Question: Write a single sentence explaining what this figure depicts.
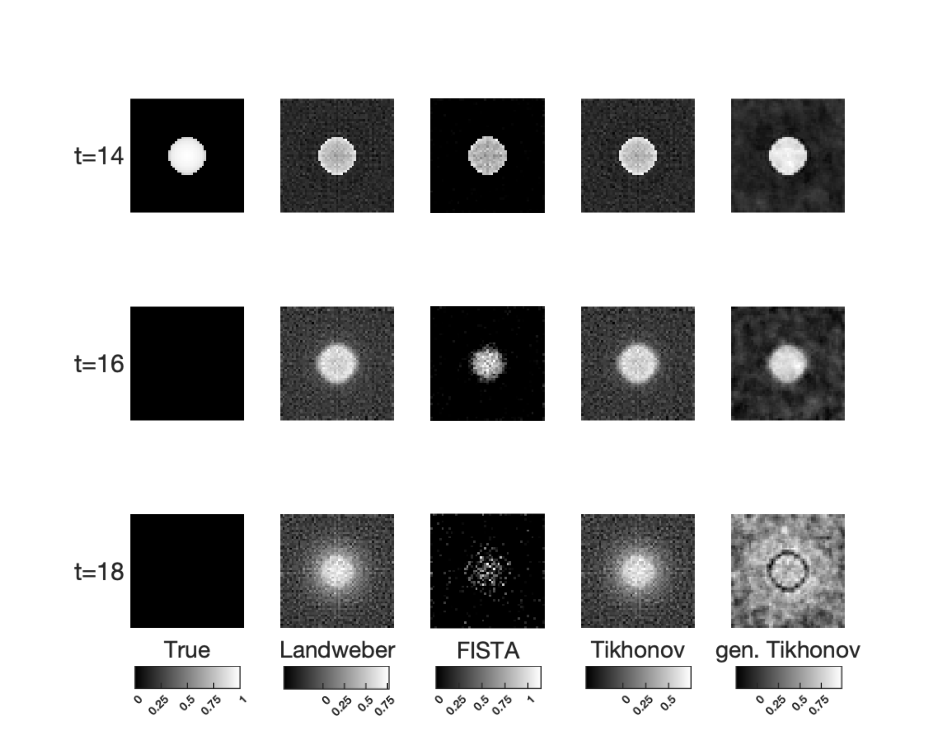
Answer: Selected slices of the lowest RRE string reconstructions for Example #3 with 5% noise and a = 0.05 and c = 0 for each method considered.